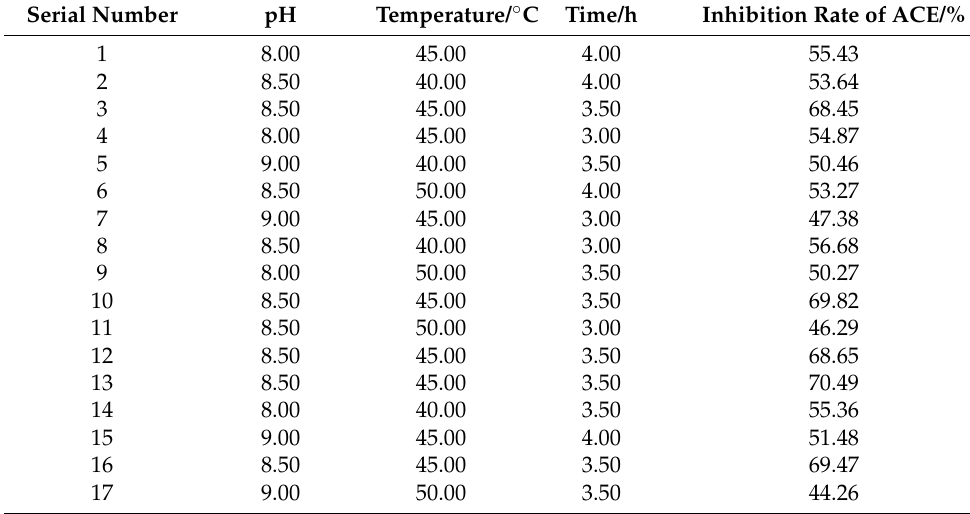
Table 2. Response surface test